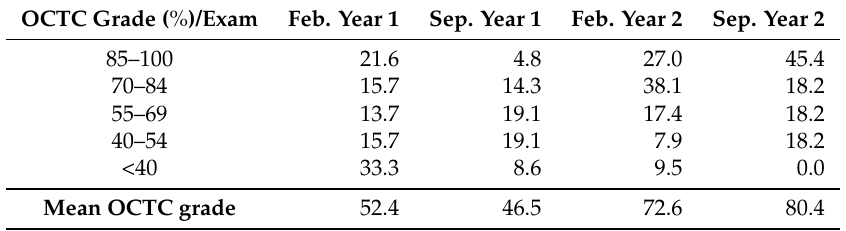
Table 3. Open-circuit-time-constant (OCTC) question performance distribution (%) for students taking the final exam, from February of the first academic year to September of the second academic year